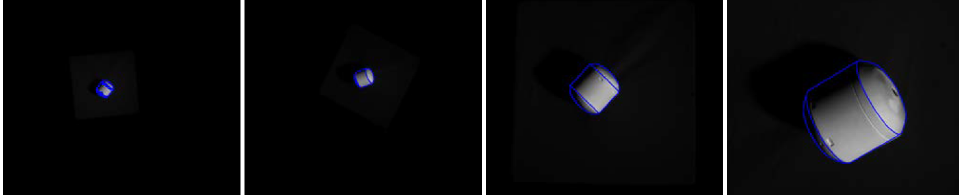
Figure 21. Example images of navigation camera during approach at distances of 15, 10, 5 and 2